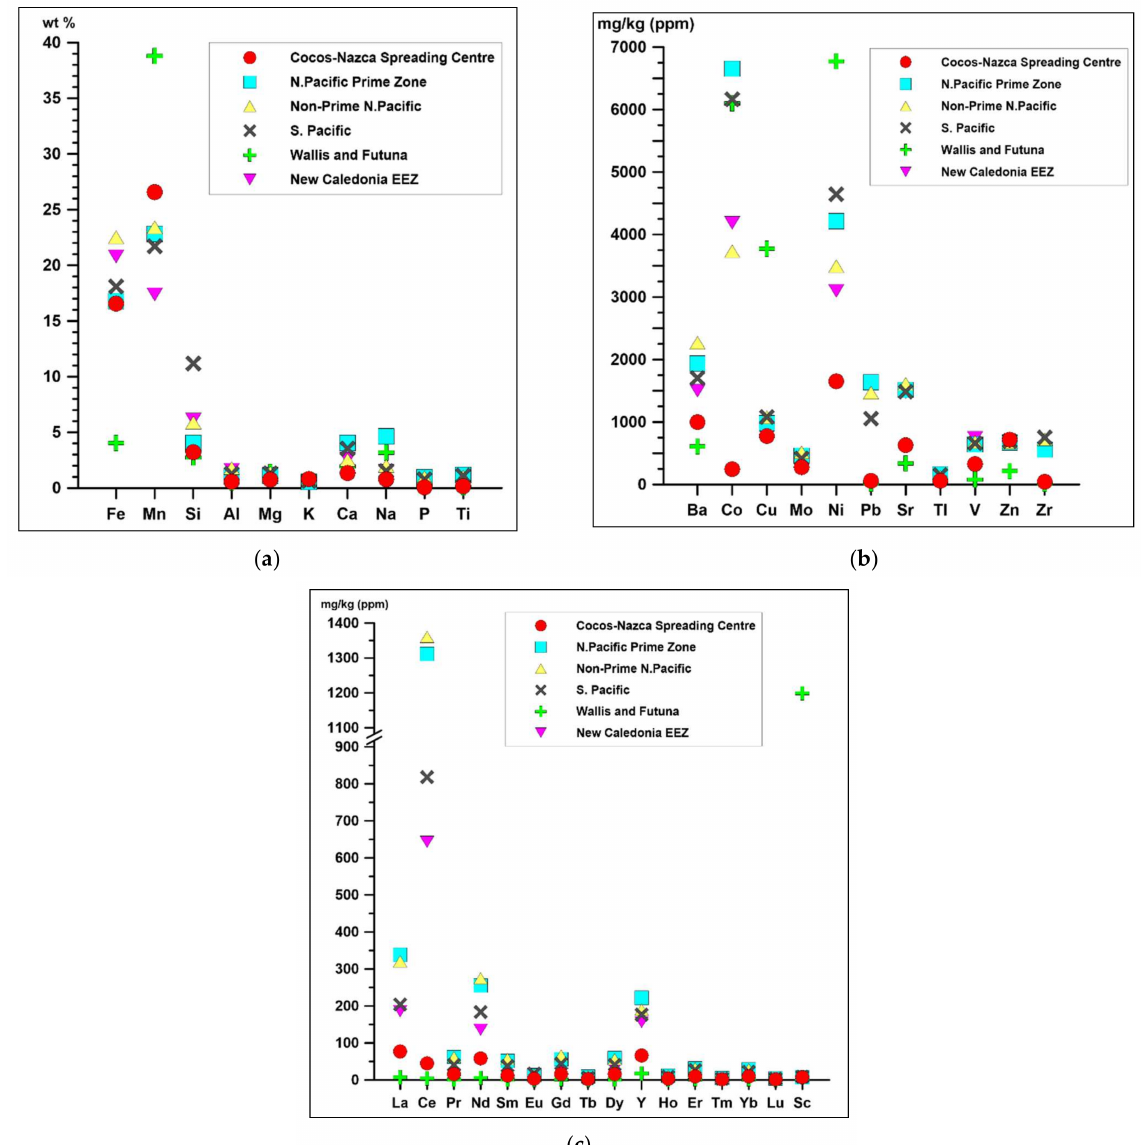
Figure 11. Mean concentrations of: ( a ) major, ( b ) trace and ( c ) rare earth elements in crusts from C-NSC against the mean values from the other Pacific regions [21]; Wallis and Futuna [75]; New Caledonia Exclusive Economic Zone [102]. There is no Mo, Tl, Tm concentration data for [75] and Tm, Sc for